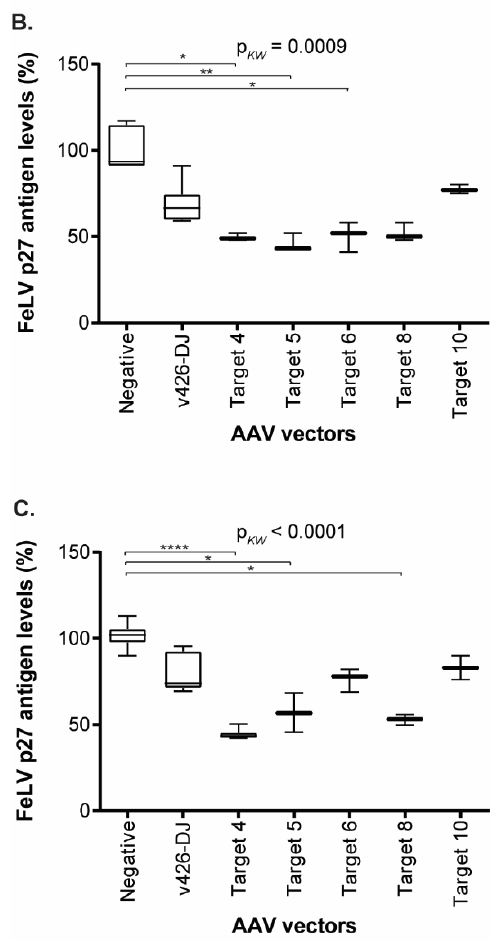
Figure 8. FeLV p27 antigen levels, after transduction in supernatant of CRFK ( A ), FEA ( B ), and PG-4 ( C ) cells. Comparison of FeLV p27 antigen levels after transduction with the AAV-DJ vector without target (v426), Target 4 (vT4), Target 5 (vT5), Target 6 (vT6), Target 8 (vT8), Target 10 (vT10), and non-transduced cells (negative). Since several individual experiments were compared, ultimate normalization of p27 values was performed to the p27 means of the non-transduced control cells (equaling 100%). FeLV p27 antigen levels were tested for significant differences by Kruskal–Wallis one-way ANOVA by ranks ( p KW as indicated) and subsequently by Dunn’s post-test: * = p < 0.05; ** = p < 0.01; **** = p < 0.0001. The data are shown as box plots; the boxes extend from the 25th to 75th percentiles. The horizontal line represents the median, and the whiskers extend from the smallest to the largest value.